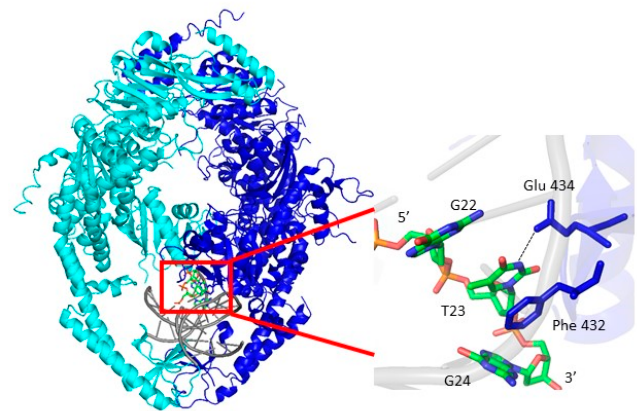
Figure 9. Structural details of the mismatch binding domain of hMsh6 interacting with G:T mismatched DNA as determined by X-ray crystallography. Stabilization of the thymine in the G:T mismatched bp through stacking of the conserved Phe 432 from the 3 ′ side and hydrogen bonding of the conserved Glu 434 is highlighted. Phe 432 and Glu 434 are shown in blue, the nucleic acid residues are shown in elemental colors and the Msh2 subunit is shown in teal. The structure was generated using PyMol and the PDB file 2O8B.